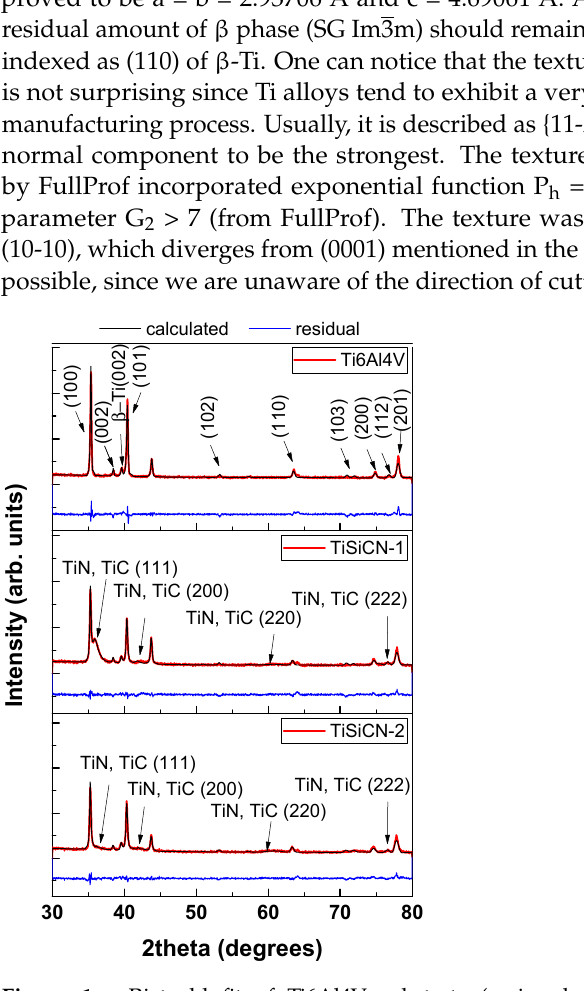
Figure 1. Rietveld fit of Ti6Al4V substrate (main phases— α -Ti [97.84 (2.16) wt.%] and β -Ti [2.16 (0.19) wt.%], TiSiCN-1, and TiSiCN-2.